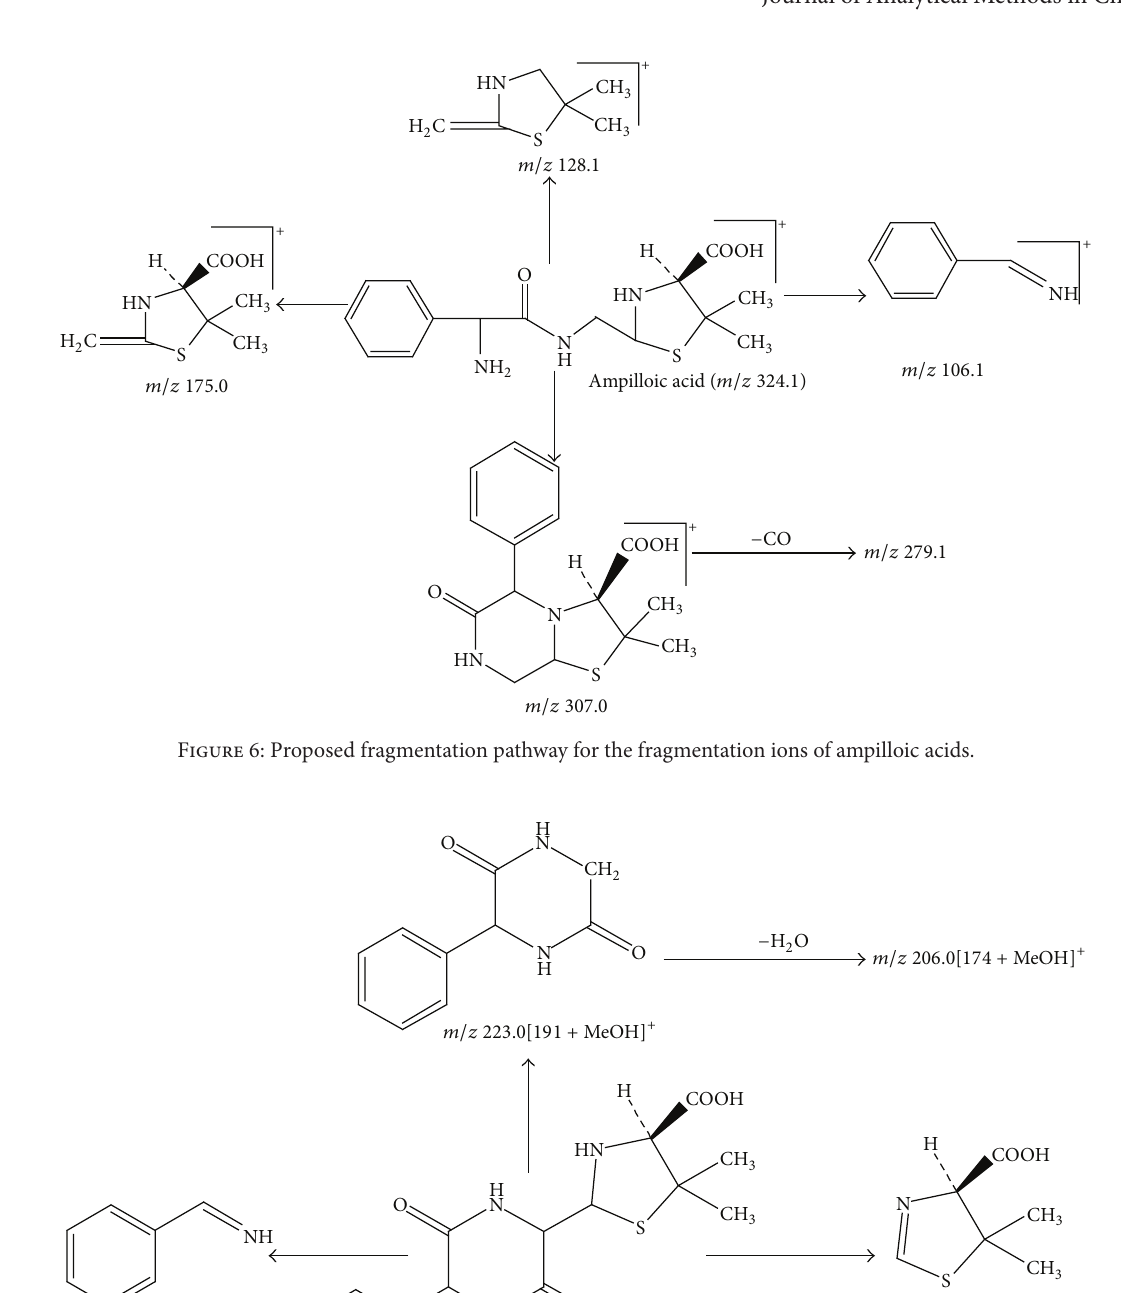
as diketopiperazines of ampicillin. Figure 7 showed the pro- posed MS fragmentation pathway for the fragmentation ion of diketopiperazines of